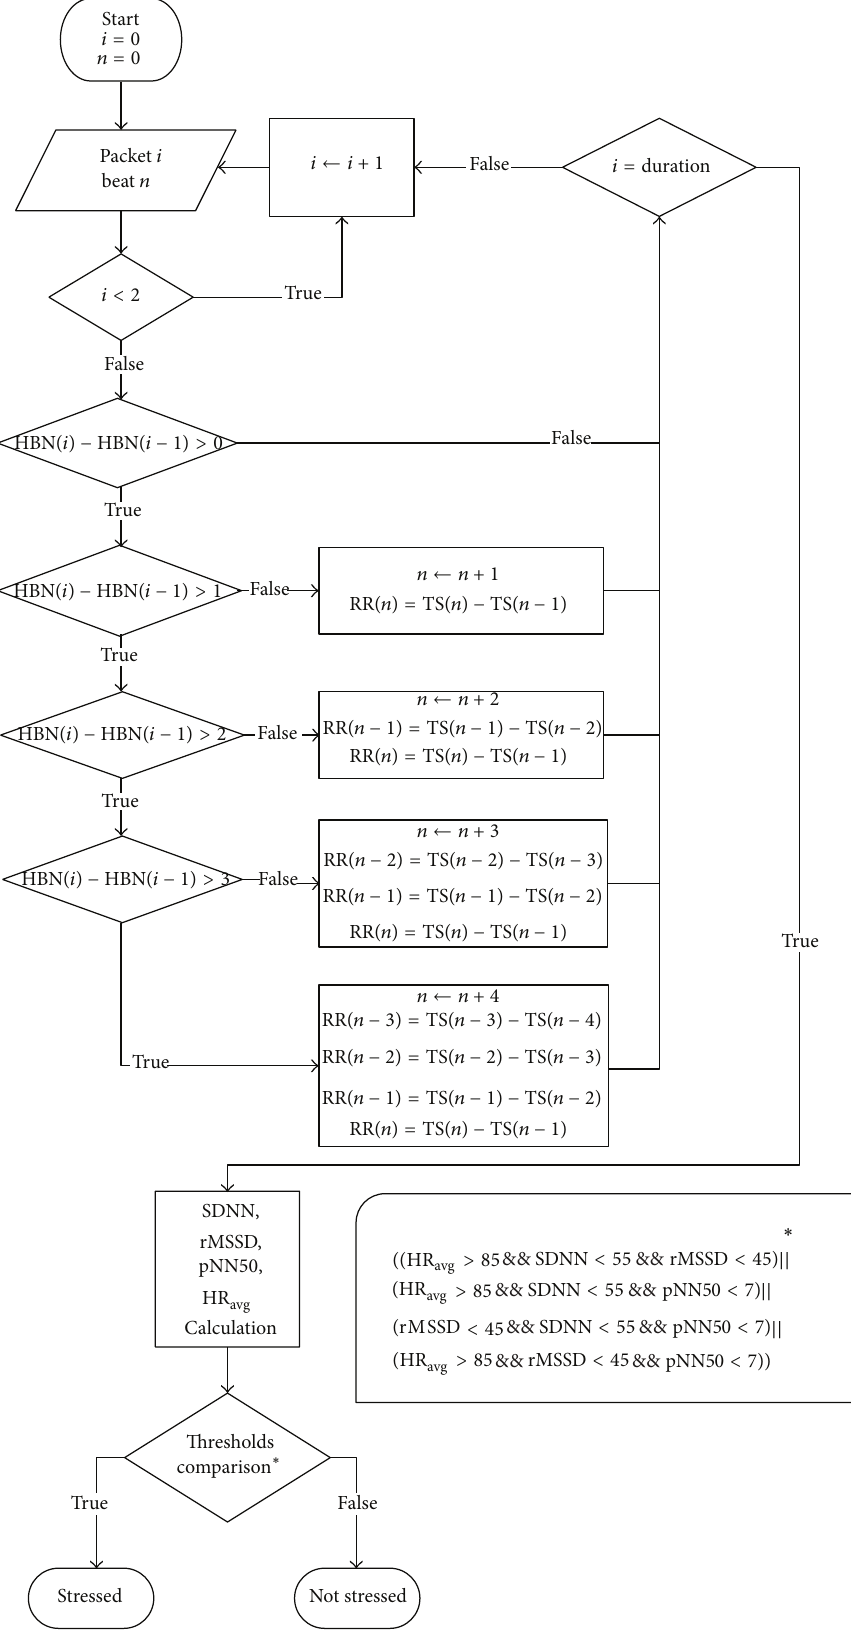
Figure 2: Stress test algorithm block